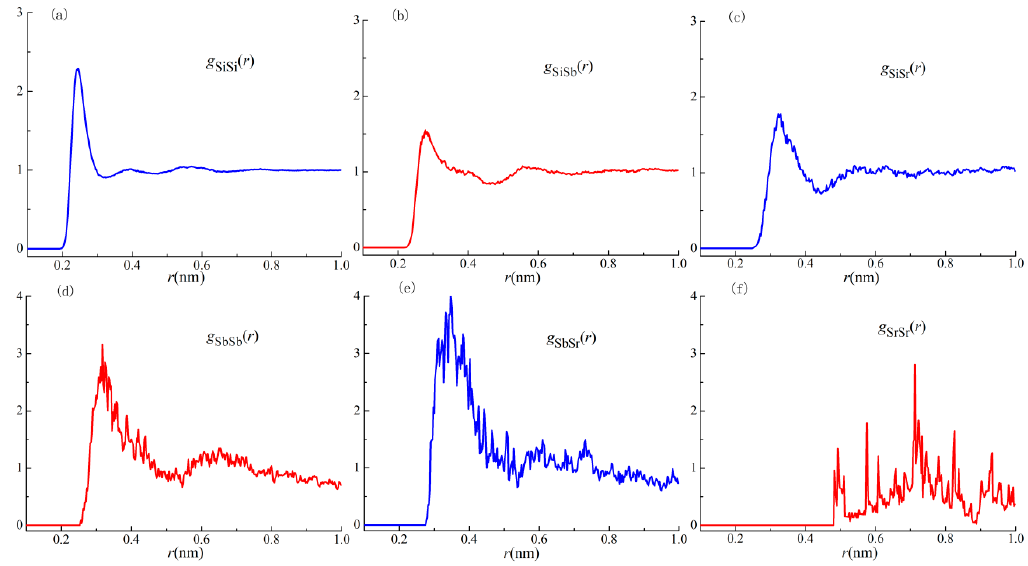
Figure 6. PDFs in the Si–18.2Sb–2.6Sr melts. Table 3. Calculated partial coordination number (Ni-j) and chemical short-range order (CSRO).